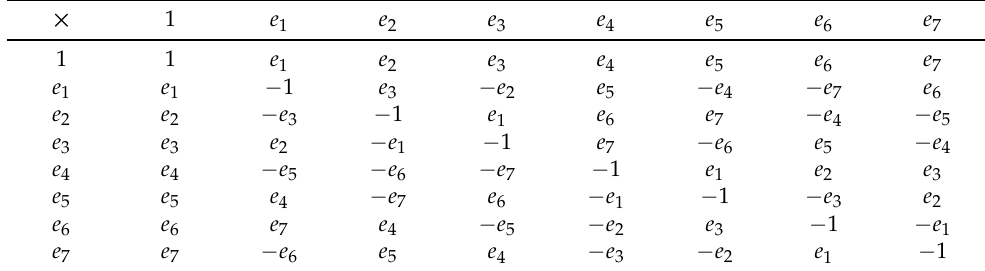
Table 1. Rules for multiplying the octonion imaginary